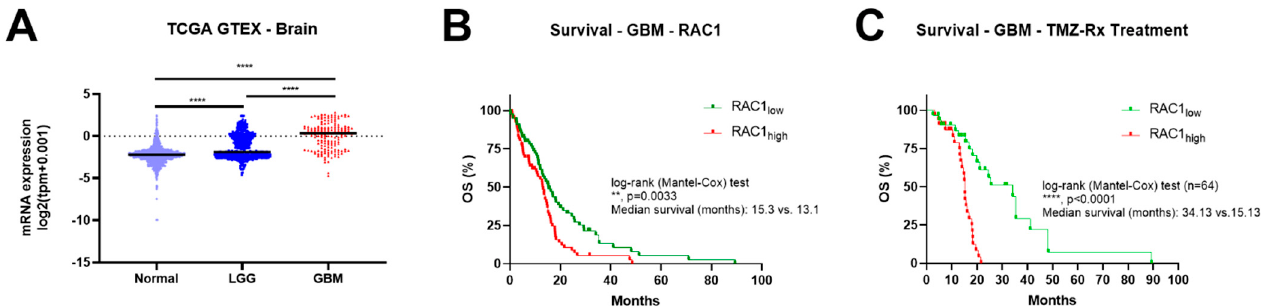
Figure 1. Rac1 levels in glioma patients from GTEX-TCGA LGG-GBM. ( A ) Transcriptomic data of Rac1 expression in normal tissue (GTEX) and in low-grade gliomas (LGG with IDH1 mutated) or GBM tumor biopsies. **, p < 0.001; ****, p < 0.0001. ANOVA, Tukey’s multiple comparisons test. ( B ) Overall survival (OS) curves of GBM patients stratified according to Rac1 levels (Rac1low vs. Rac1high). ( C ) Overall survival (OS) curves of GBM patients that received TMZ and/or radiotherapy (Rx) as treatment stratified according to Rac1 levels (Rac1low vs.